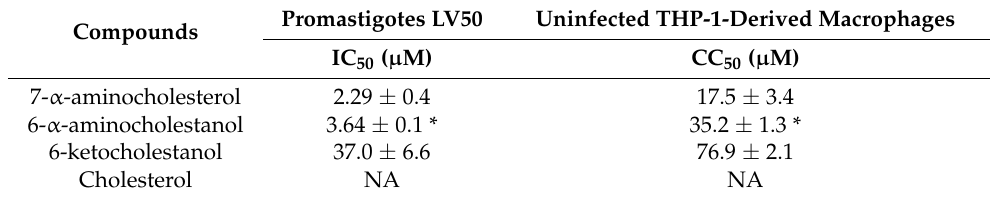
Table 3. Summary of the in vitro effects of the cholestanol and sterol derivatives on the viability of the promastigotes and noninfected THP-1